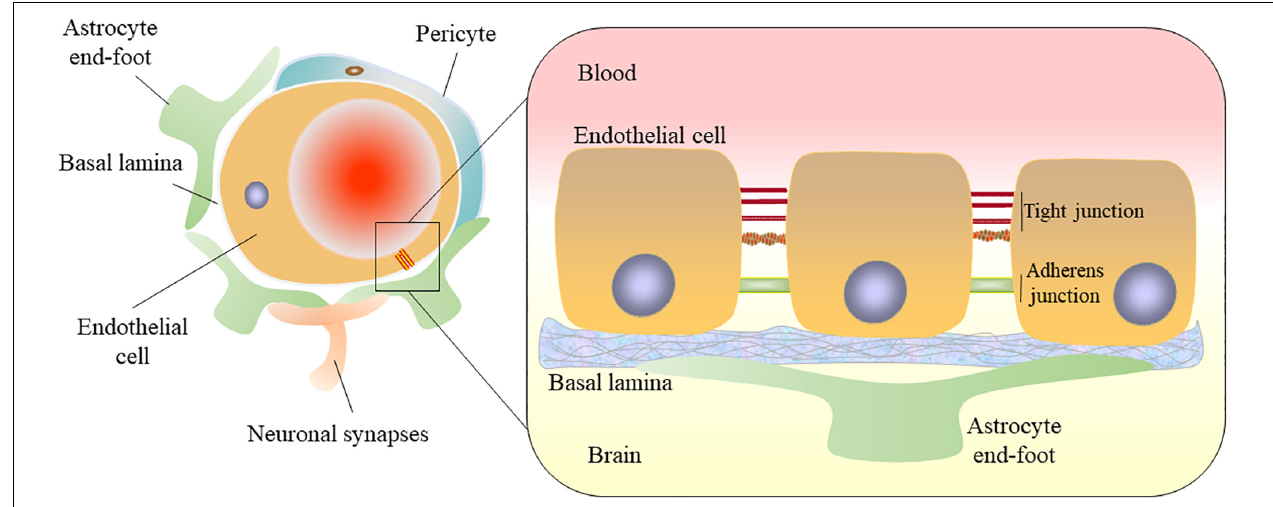
FIGURE 1 | Structural diagram of the blood-brain barrier. The blood-brain barrier (BBB) consists of microvascular endothelial cells. Endothelial cells are connected by tight junctions and adherens junctions. The BBB surrounded by basal lamina, pericytes, and astrocytic perivascular end-feet in the neurovascular unit (NUV). Astrocytes provide the cellular link to the neurons. All of these come together to maintain the BBB structural and functional integrity.